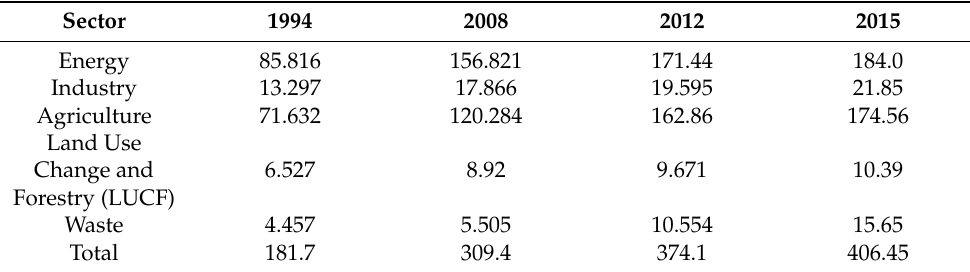
Table 6. Sector wise GHG emissions in Pakistan in 1994, 2008, 2012, and 2015 (MtCO 2 -eq)